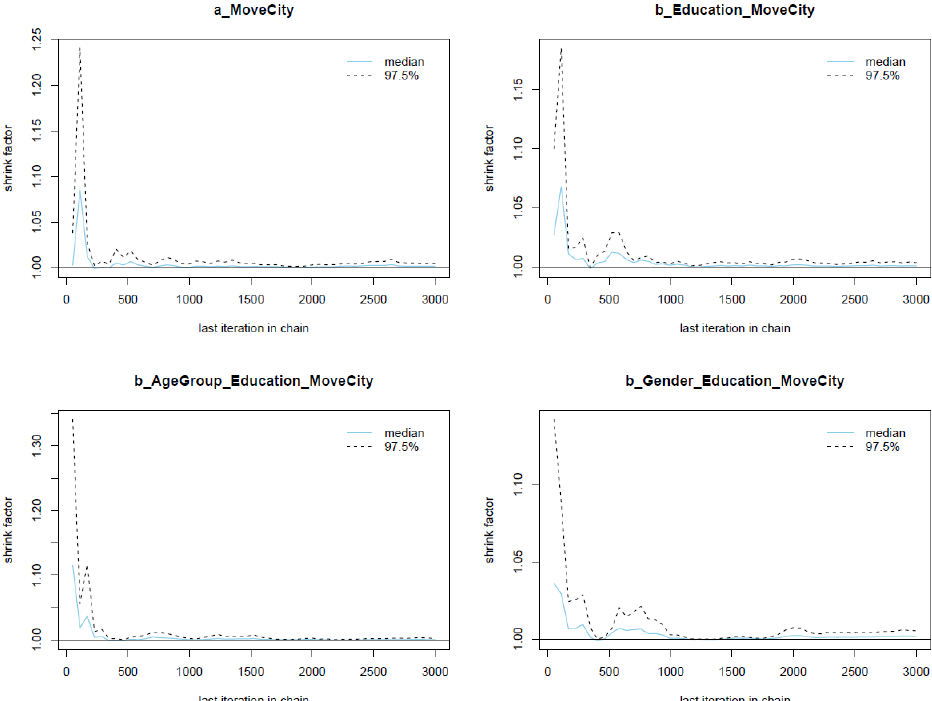
(cid:48) s posterior Figure 4. Gelman plots for Model 1′s posterior parameters. Figure 4. Gelman plots for Model 1 Figure 4. Gelman plots for Model 1′s posterior parameters.